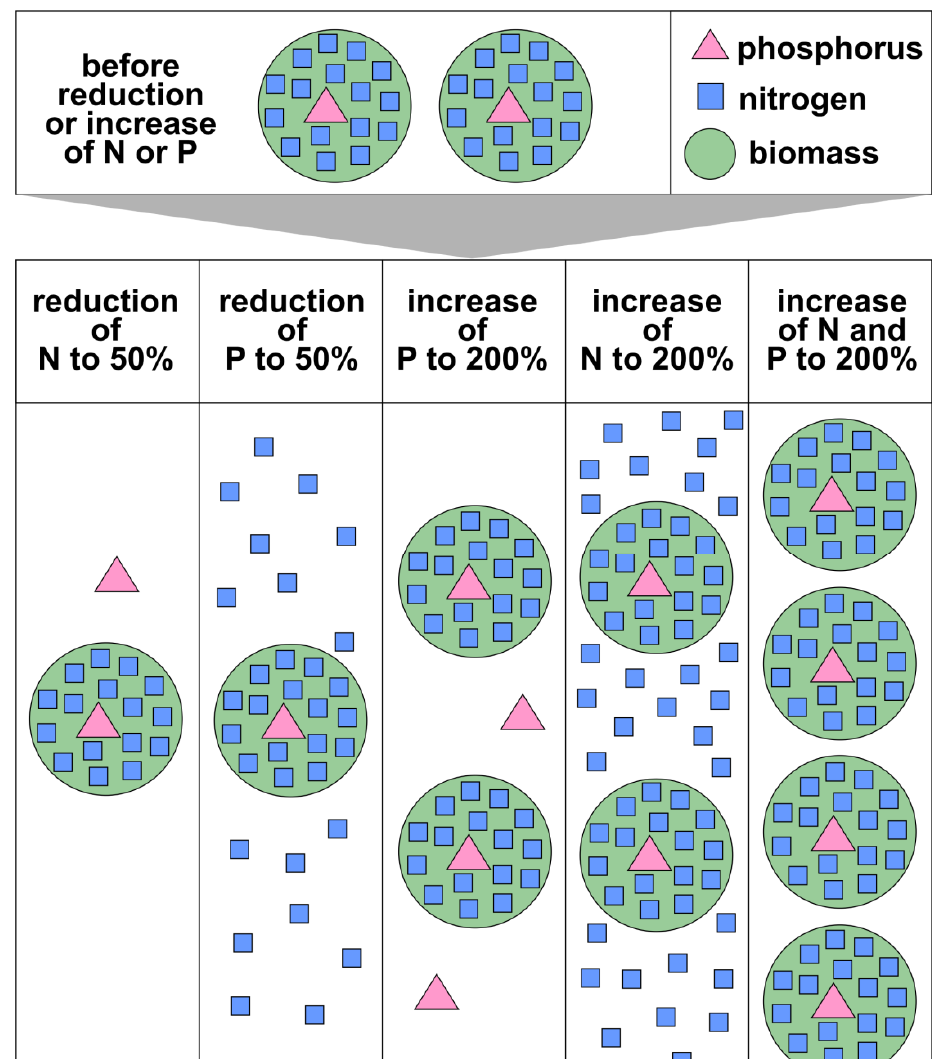
Figure 1. Schematic illustration of the impact of increasing or reducing nitrogen (N, blue squares) and phosphorus (P, pink triangles) concentrations, either individually or both, in a moderately eutrophic situation in which cellular uptake has depleted dissolved N and P and both nutrients are incorporated in cells (green circles). Nutrients that are not incorporated into biomass remain in the dissolved fraction outside of cells.